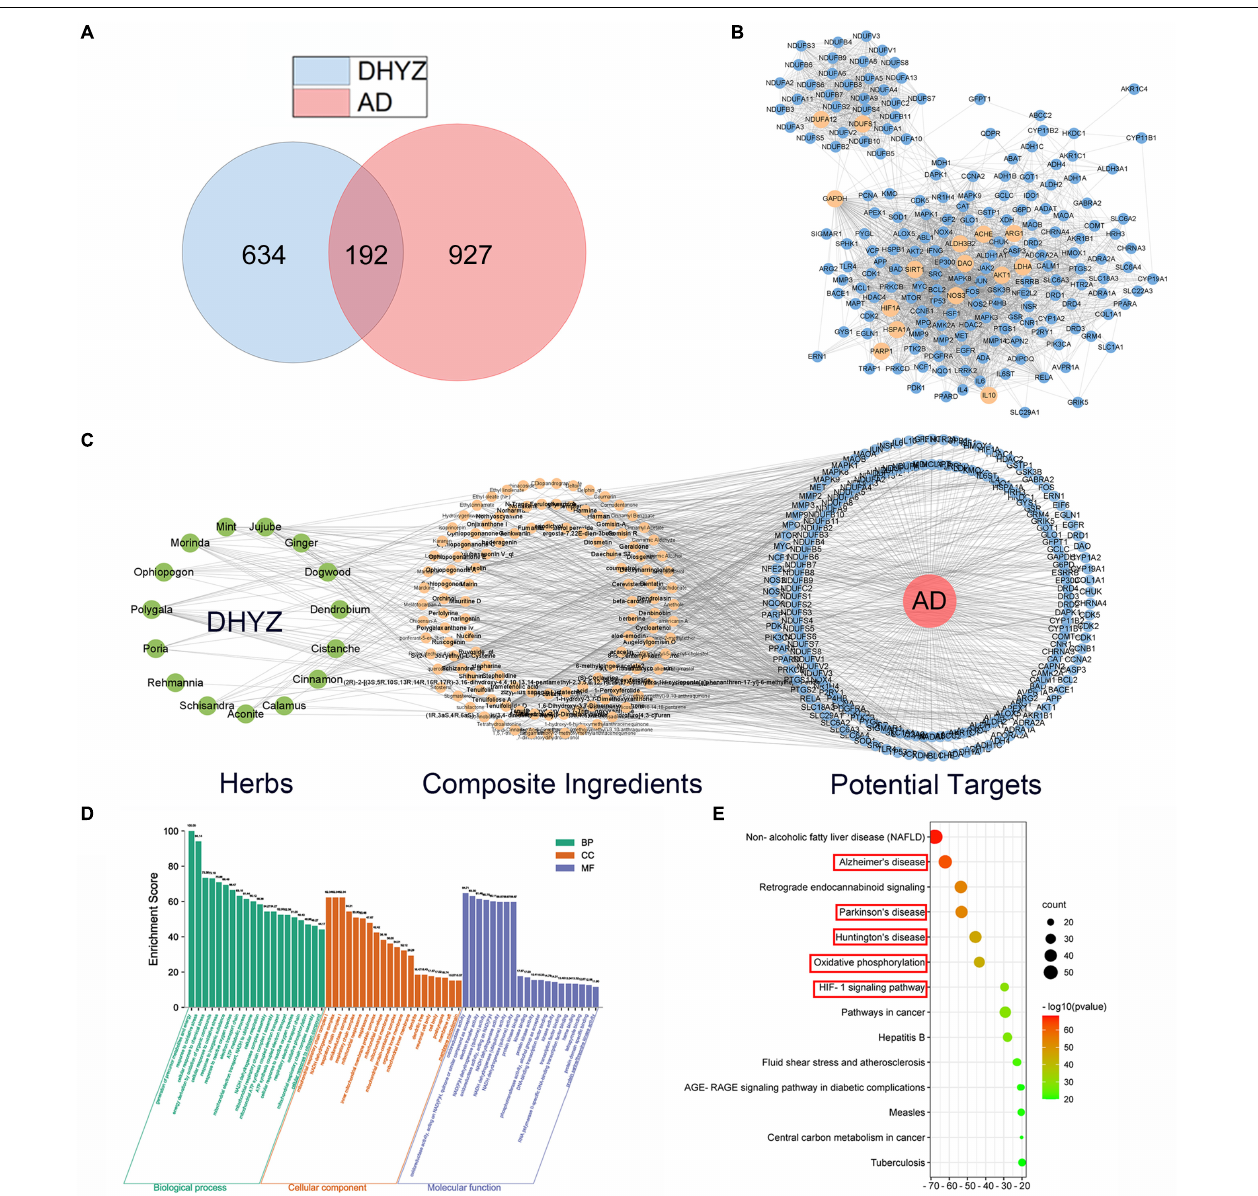
FIGURE 4 | Network pharmacology analysis of DHYZ against AD. (A) Venn diagrams of the targets of DHYZ and AD, and common-targets of DHYZ against AD. (B) The protein-protein interaction network of targets of DHYZ against AD. The nodes with faint yellow color represent the hub genes. (C) The herbs-composite ingredients-potential targets network of DHYZ in the treatment of AD. The green, faint yellow, and blue nodes represent herbs that makeup DHYZ, composite ingredients, and the potential target genes, respectively. GO enrichment (D) and KEGG pathway enrichment analyses (E) were performed to probe the biological function and potential mechanisms of 192 potential target genes of DHYZ in treating AD. GO, gene ontology; KEGG, Kyoto Encyclopedia of Genes and Genomes; BP, biological processes; CC, cell components; MF, molecular functions; AD, Alzheimer’s disease; DHYZ,